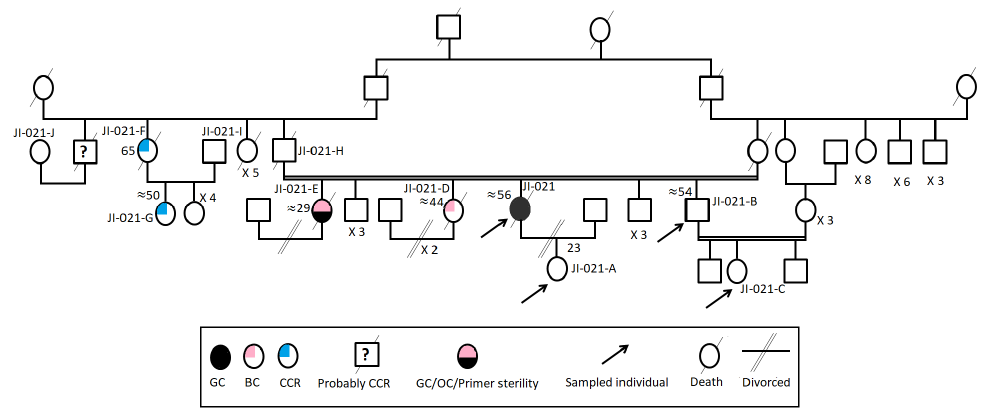
Figure 1. The familial pedigree of the index case “JI-021”. It included gastric, colon, breast and ovarian cancers. It showed a tumor spectrum typical of LS II form. Table 1. Description of clinicopathological features and family history of the index case.